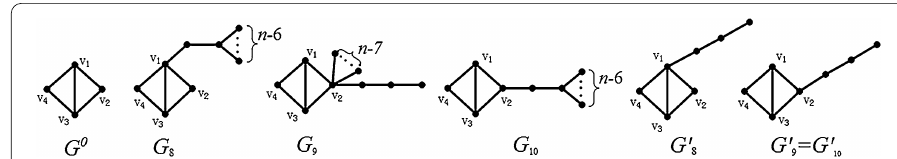
Figure 10 Some bicyclic graphs with θ (2,3,3) as their